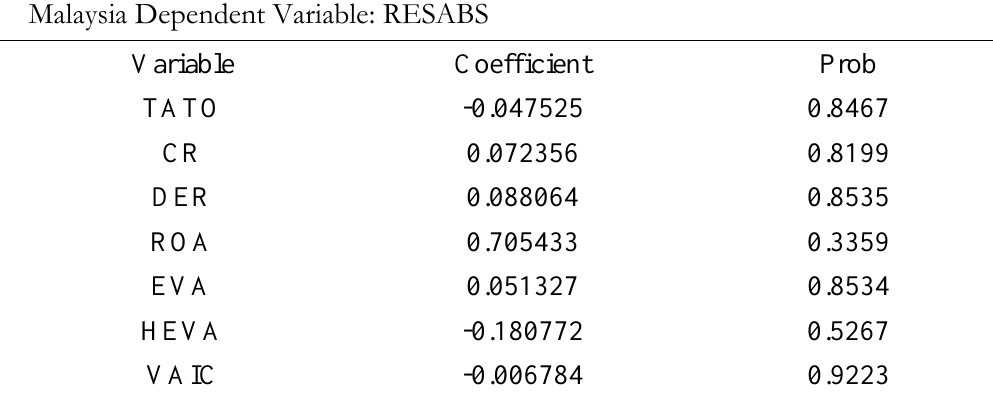
Heterokedasticity Test Results for Energy Companies